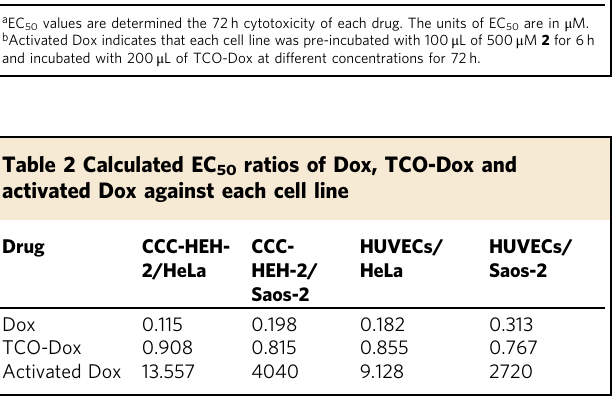
a EC 50 values are determined the 72h cytotoxicity of each drug. The units of EC 50 are in μ M. b Activated Dox indicates that each cell line was pre-incubated with 100 μ L of 500 μ M 2 for 6h and incubated with 200 μ L of TCO-Dox at different concentrations for 72h.